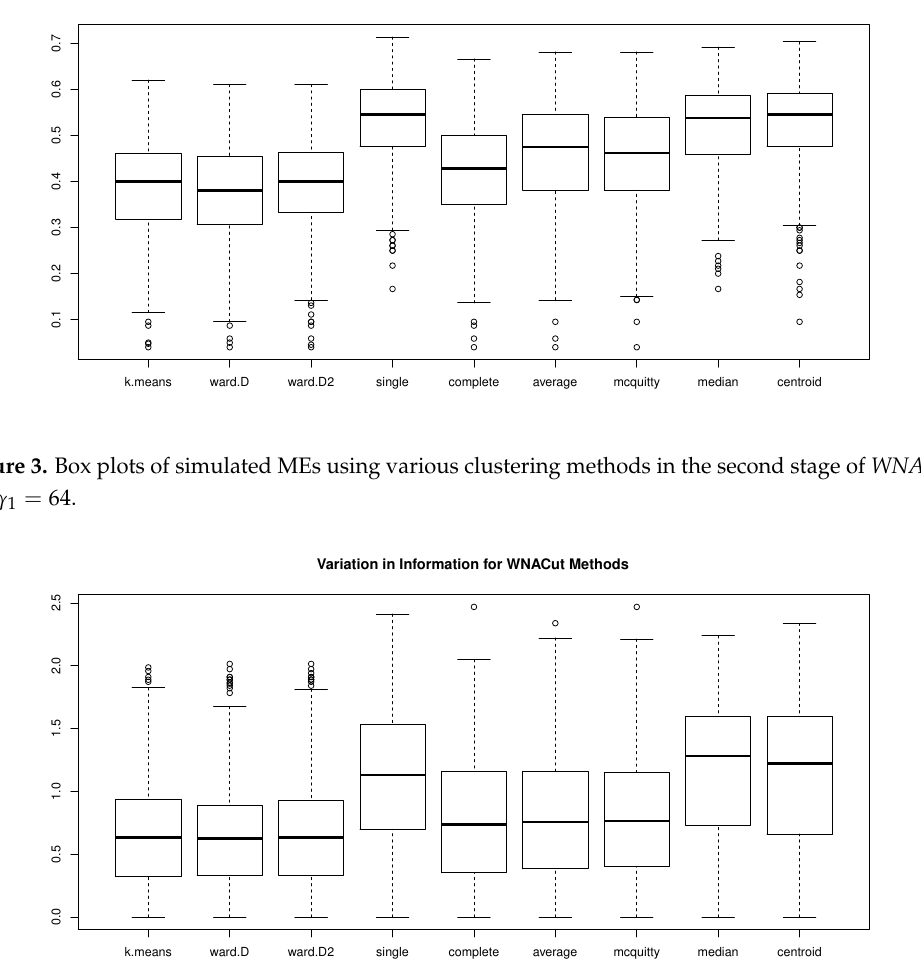
Figure 4. Box plots of simulated VIs using various clustering methods in the second stage of WNACut for γ 1 =